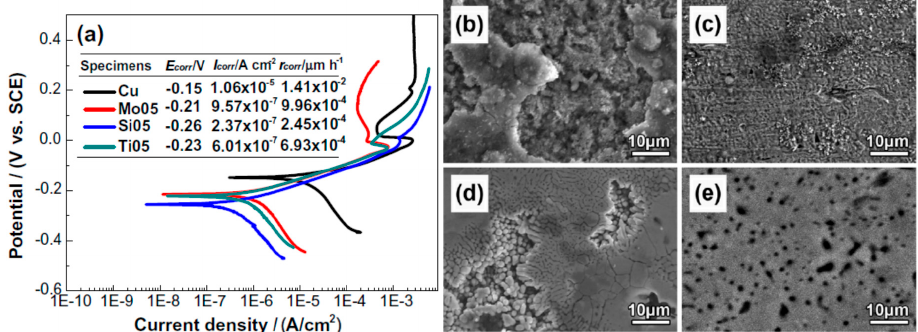
Figure 15. ( a ) Potentiodynamic polarization plots of AlCoCrCuFe- X 0.5 CCA coatings, SEM microgarphs of surface morphologies after polarization tests for ( b ) X = Cu, ( c ) X = Si05, ( d ) X = Mo05, and ( e ) X = Ti05 [60] (reprinted with permission from Elsevier).